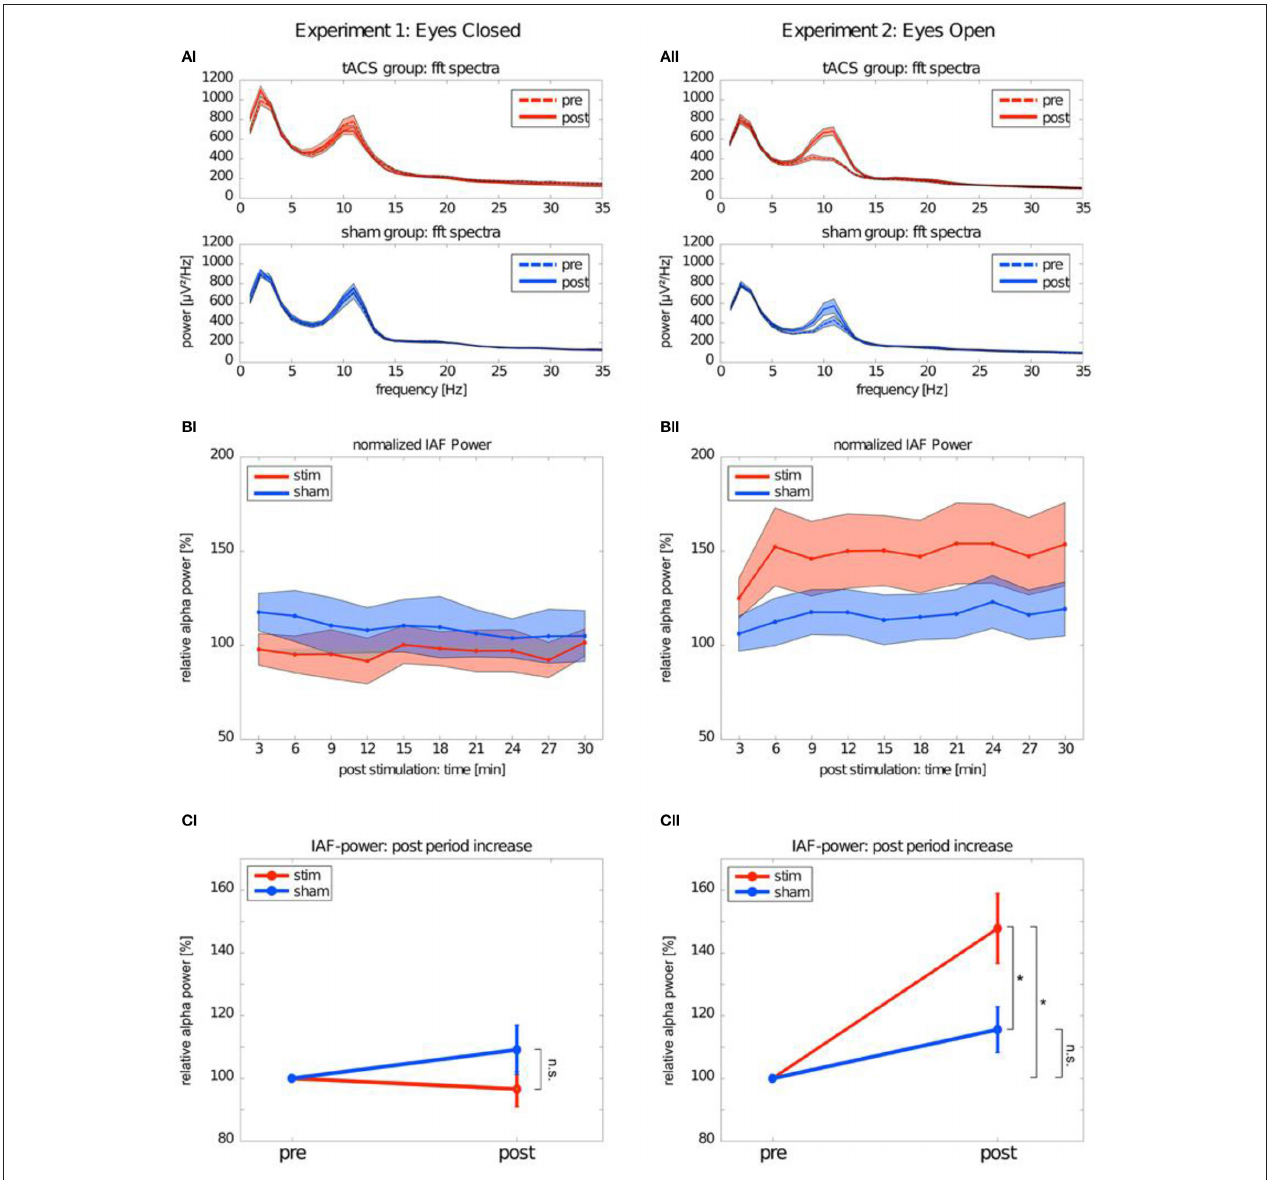
FIGURE 1 | Alpha band after transcranial alternating current stimulation (tACS). This figure depicts the difference in EEG power spectrum between Experiment 1: Eyes-closed and Experiment 2: Eyes-open conditions. (AI) tACS group:fft spectra depicts pre- and post-stimulation changes in power spectrum for EEG frequencies in real tACS in eyes-closed condition. Axis y stays for power values (microvolts) and axis x stands for frequency values (Hz). tACS group: fft spectra depicts pre- and post-stimulation changes in power spectrum for EEG frequencies in sham tACS in eyes-closed condition. (BI) Normalized IAF power represents pre- and post-stimulation difference in relative power of individual alpha frequency (IAF) in real tACS group in eyes-closed condition. Axis y stays for power values (microvolts) and axis x stands for frequency values (Hz). (CI) IAF power post period increase represents pre- and post-stimulation difference in relative alpha power between stim and sham in eyes-closed condition. (AII) tACS group:fft spectra depicts pre- and post-stimulation changes in power spectrum for EEG frequencies in real tACS in eyes-open condition. Axis y stays for power values (microvolts) and axis x stands for frequency values (Hz). tACS group: fft spectra depicts pre- and post-stimulation changes in power spectrum for EEG frequencies in sham tACS in eyes-open condition. (BII) Normalized IAF power represents pre- and post-stimulation diference in relative power of individual alpha frequency (IAF) in real tACS group in eyes-open condition. Axis y stays for power values (microvolts) and axis x stands for frequency values (Hz). (CII) IAF power post period increase represents pre- and post-stimulation difference in relative alpha power between stim and sham in eyes-open condition. The symbol *represents the diference in post-stimulation alpha power between stim and sham group in eyes-open condition. [with the author’s permission, taken from Neuling et al.